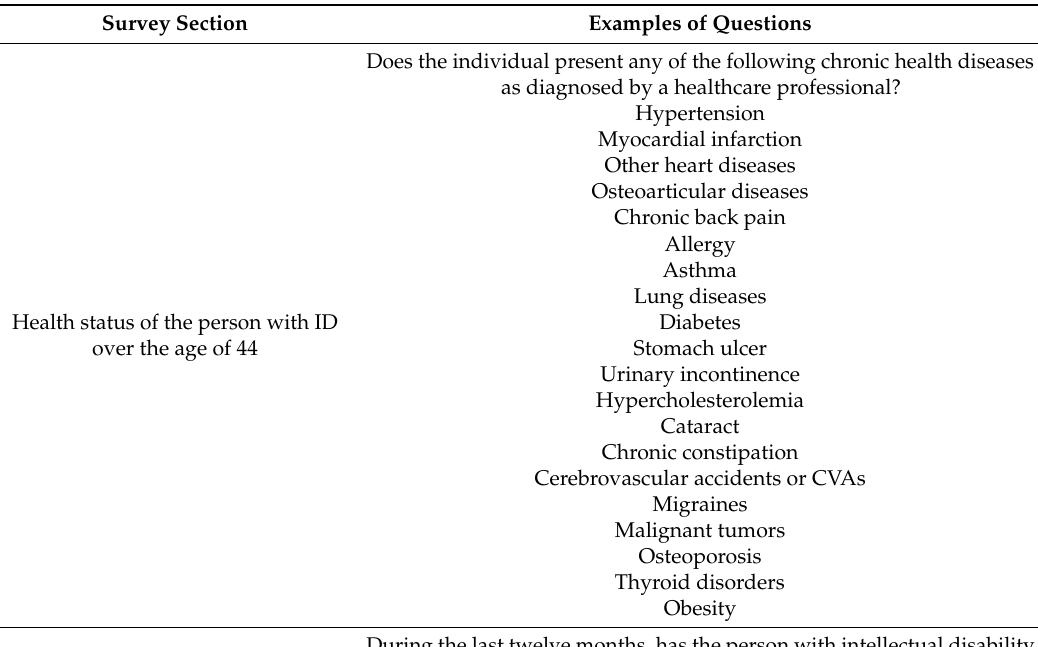
Table 3. Examples of questions included in the